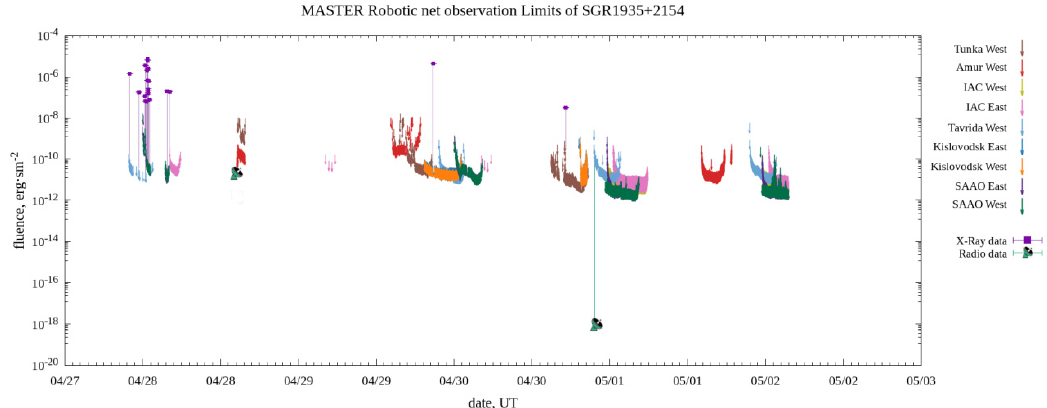
Figure 10. The limiting fluence of optical emission achieved by the MASTER in the process of observing the repeater SGR/FRB 1935+2154. These are not corrected for the Galaxy absorption. The most powerful fluences of the gamma-ray range (Fermi, INSIGHT), which fell at the time of our exposure, are shown in purple. Small radio telescopes show radio fluence on 28 April and 30 April. The second radio burst on April 30 was very weak but was coincident with our frame [90].